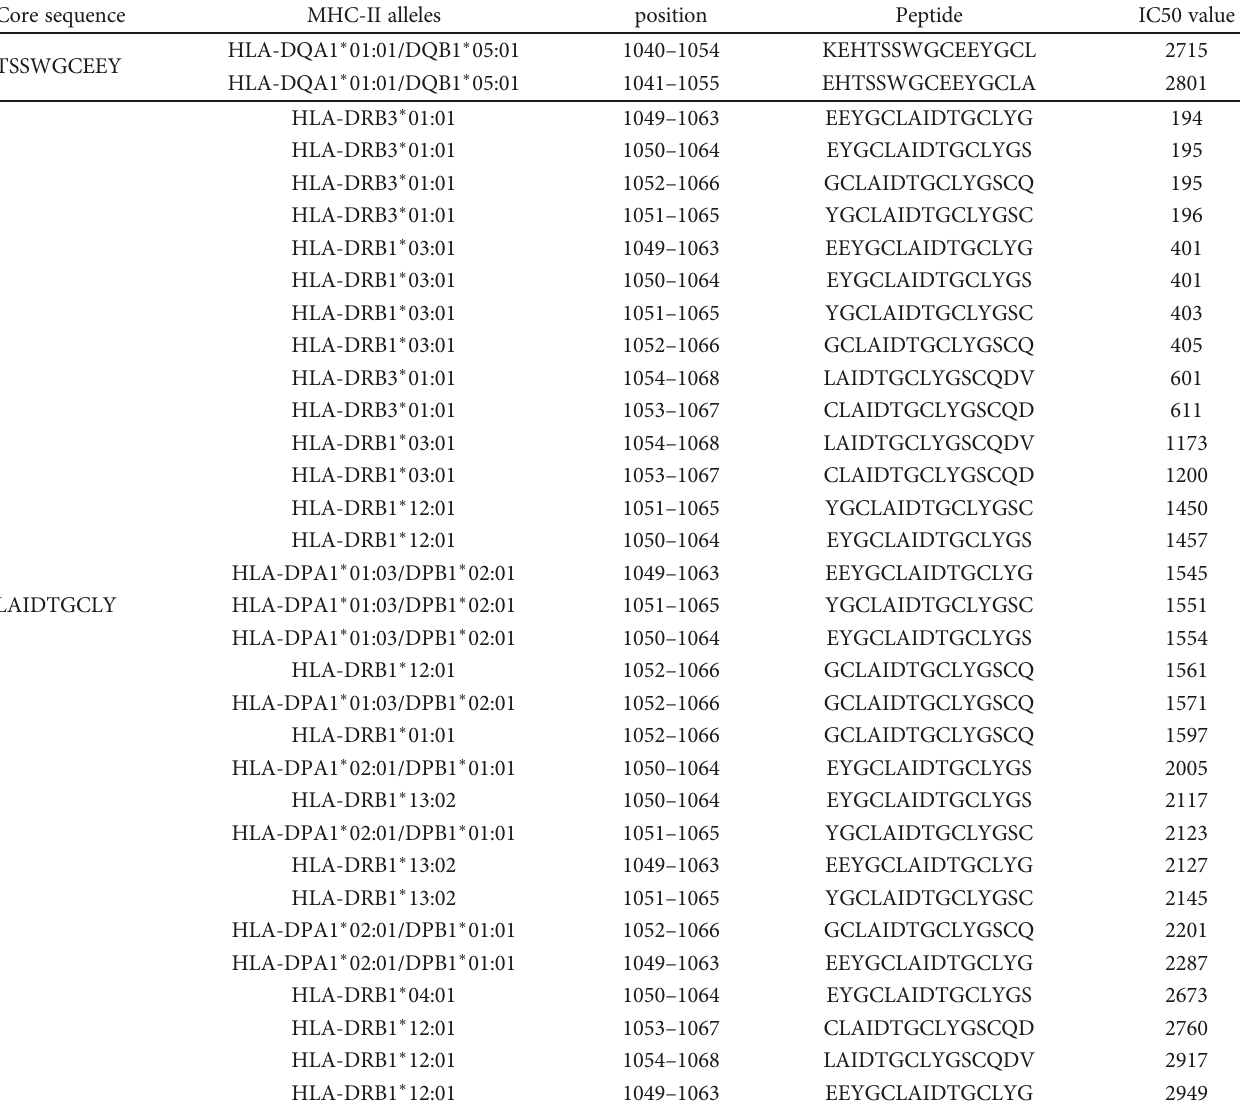
Table 2: MHC-II alleles for the desired